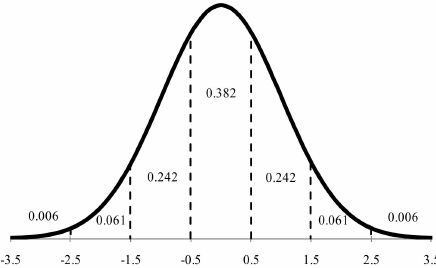
Figure 2. Seven-step approximation of a typical normal density